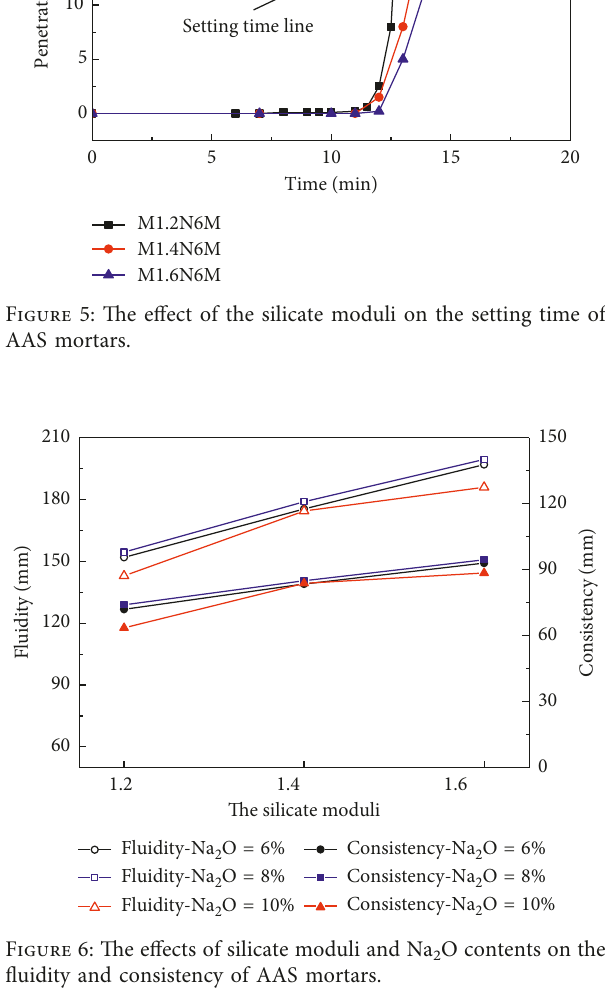
2 O contents on the